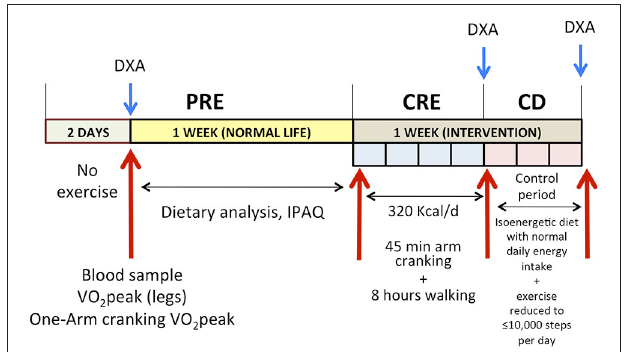
FIGURE 1 | Schematic illustration of the experimental protocol. PRE, baseline tests; CRE, caloric restriction (13.4 kJ/day) and exercise (45 min arm cranking and 8 h walking per day), for 4 days; CD: 3 days on a diet, isoenergetic with that observed during the PRE phase + reduced exercise; DXA, dual-energy x-ray absorptiometry; IPAQ, international physical activity questionnaire.